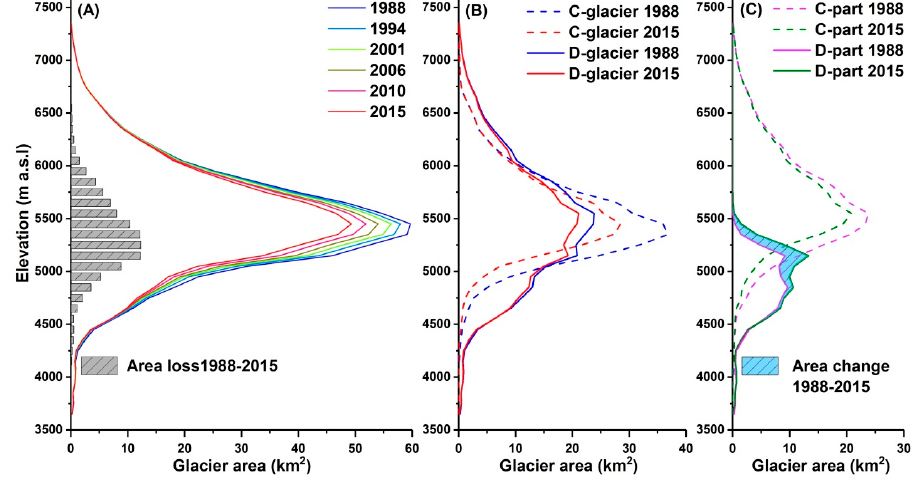
Figure 5. Altitudinal distribution of glaciers and their changes between 1988 and 2015: ( A ) distributions of glacier areas and the net area loss; ( B ) area distributions of C-glaciers and D-glaciers; ( C ) area distributions and changes of C-part and D-part glaciers. The shaded area in ( C ) is only the area increase in D-parts.